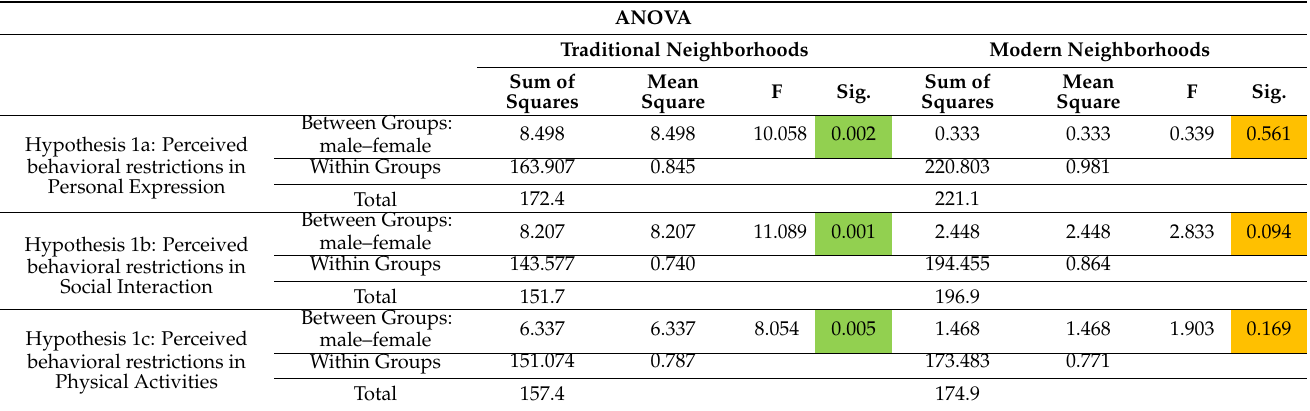
Table 2. ANOVA analysis exploring significant gendered behavioral differences in two districts, hypothesis